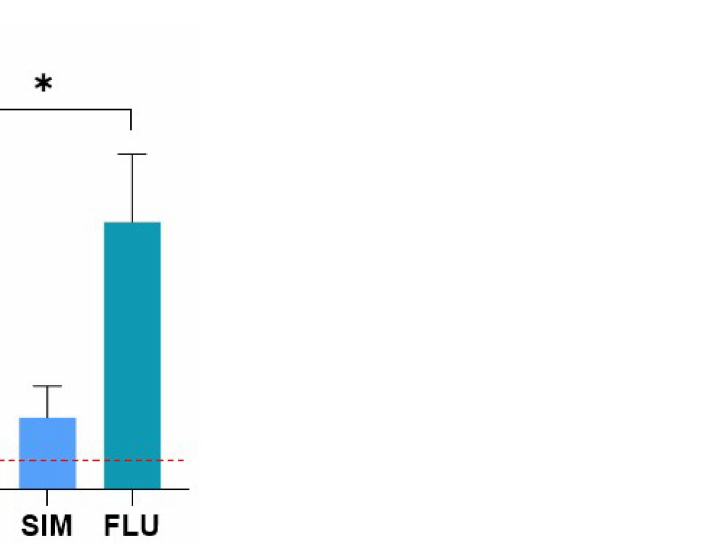
Figure 4. Impact of statins on the mitochondrial superoxide level of PC-3 cells exposed 24 h to simvastatin and fluvastatin (10 µ M). Mitochondrial superoxide was measured using mitoTEMPO-H as an EPR sensor. Superoxide contribution to the signal was measured by making the difference between the signal intensities recorded in the absence and in the presence of PEGSOD2. Bars represent means ± SEM (A.U), (*) p < 0.05, one-way ANOVA, n = 3.